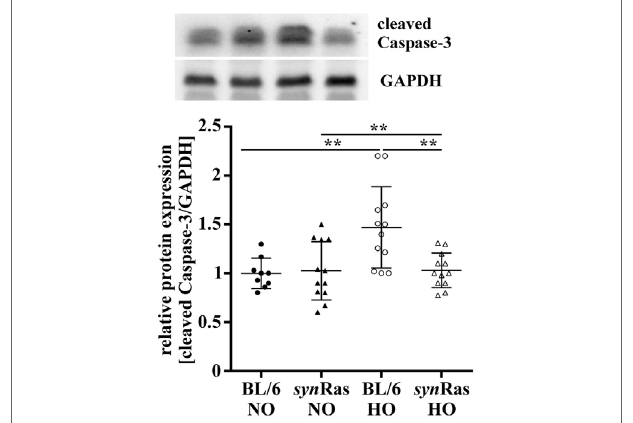
FigUre 1 | Apoptosis caused by hyperoxia is reduced in transgenic syn Ras mice. Induction of apoptosis was determined by relative protein expression analysis for cleaved Caspase-3 by Western blot in lysates from hemispheres of postnatal day 7 (P7) mice that were exposed to either normoxia [21% oxygen (NO)] or hyperoxia [24 h, 80% oxygen (HO)] at P6 in syn Ras mice or their respective wild-type littermates (BL/6). Data are represented as relative protein expression [cleaved Caspase-3/glyceraldehyde 3-phosphate dehydrogenase (GAPDH)] normalized to the control group (BL/6 NO) (** p <